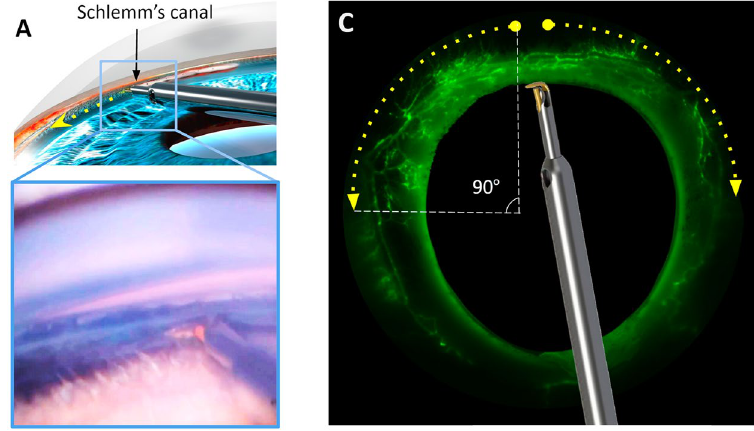
Figure 2. Schematic representation of the iridocorneal angle. ( A ) A microincisional glaucoma surgical device (trabectome) inserted into Schlemm’s canal in a human eye. Ablation is directed towards the left. ( B ) Direct gonioscopic view of the trabectome tip engaged in the trabecular meshwork in a pig eye. ( C ) A canalogram demonstrates fluorescent microspheres that enter the outflow tract only after successful ablation. Anterior chamber fluorescence is suppressed to avoid detraction from collector channel outflow. Up to 180 degrees (90 degrees on each side) of trabecular meshwork could be ablated as in this example.